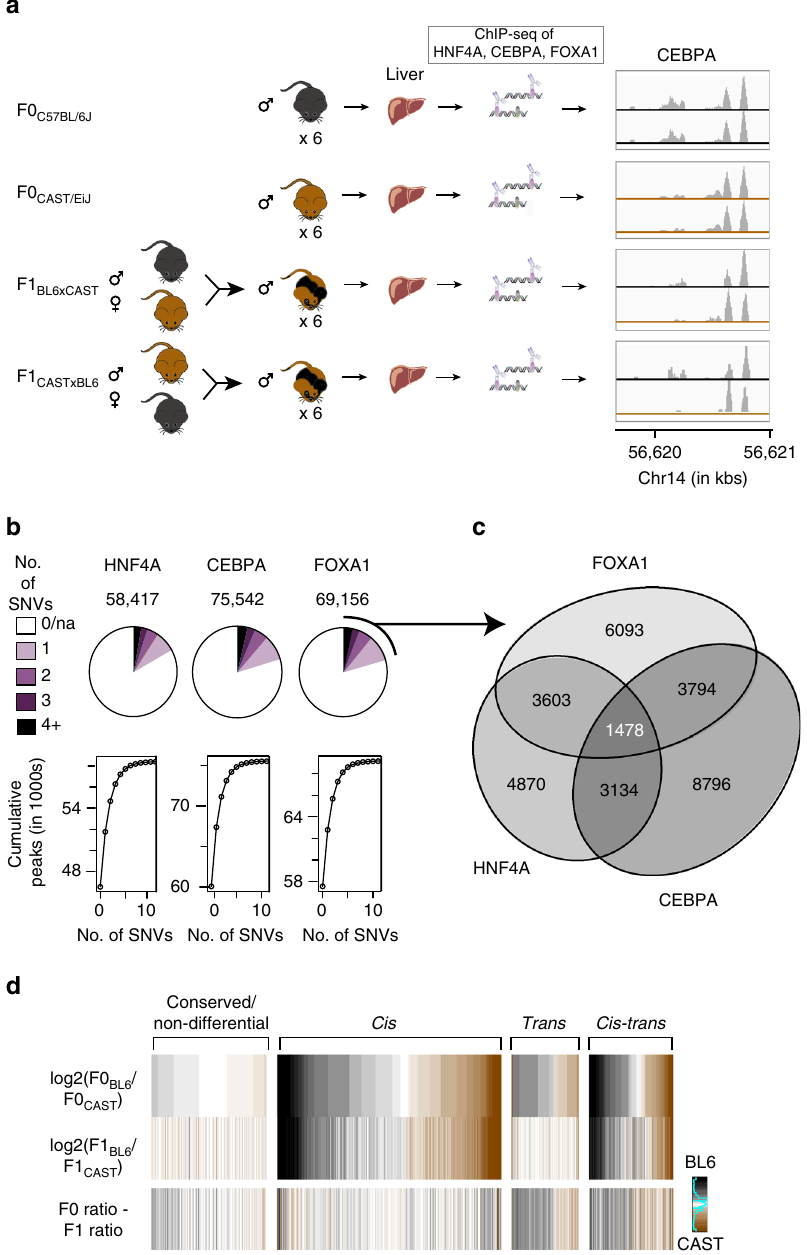
Fig. 1 F1 mice were used to interrogate the regulation of TFBS variation. a In vivo binding of liver-speci fi c TFs FOXA1, HNF4A, and CEBPA were pro fi led in the livers of male mice from inbred strains C57BL/6J (BL6), CAST/EiJ (CAST), and their F1 crosses: C57BL/6J × CAST/EiJ (BL6xCAST) and CAST/EiJ × C57BL/6J (CASTxBL6). Six biological replicates were generated for each TF and genetic background combination. b The number of TFBS that could be classi fi ed with associated number of SNVs. c Venn diagram illustrates the numbers of classi fi able SNVs that overlap between TFs. Each variant is at least 250 bp from any other SNV. Numbers shown are the fi nal numbers of regulatory loci used for downstream analyses. d Heatmap con fi rming overall accuracy of regulatory class assignments. BL6 (black) vs. CAST (brown) binding intensity ratios for different regulatory categories for CEBPA. A subset of variants from each class was randomly sampled to match the overall distribution. Sparkline in key shows the number of observations at each color category, where density is increasing from left to